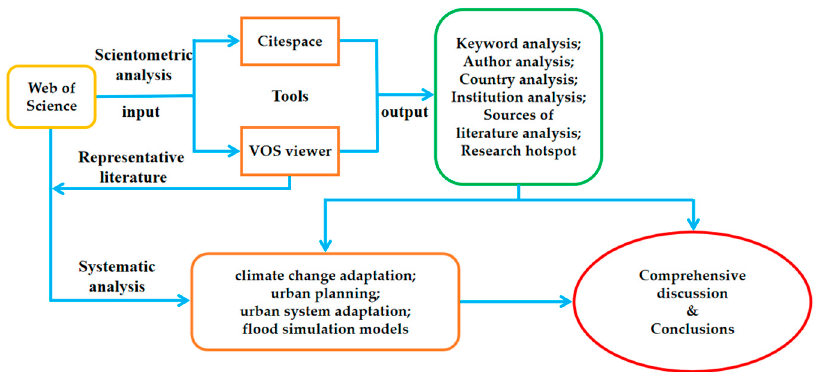
Figure 1. Process diagram of literature analysis.